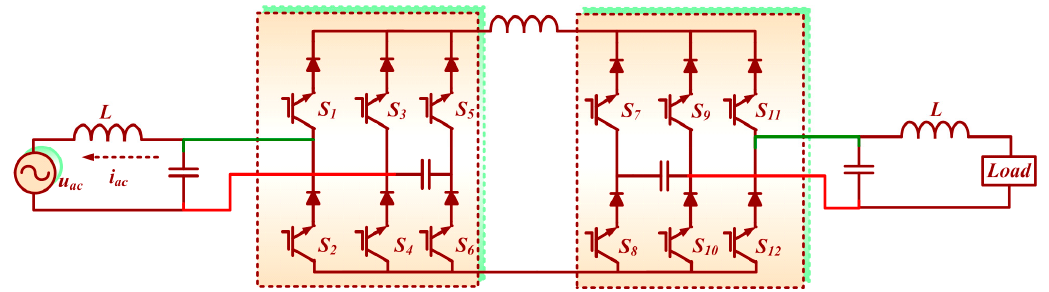
Figure 11. Current source converter with two auxiliary decoupling circuits [38].